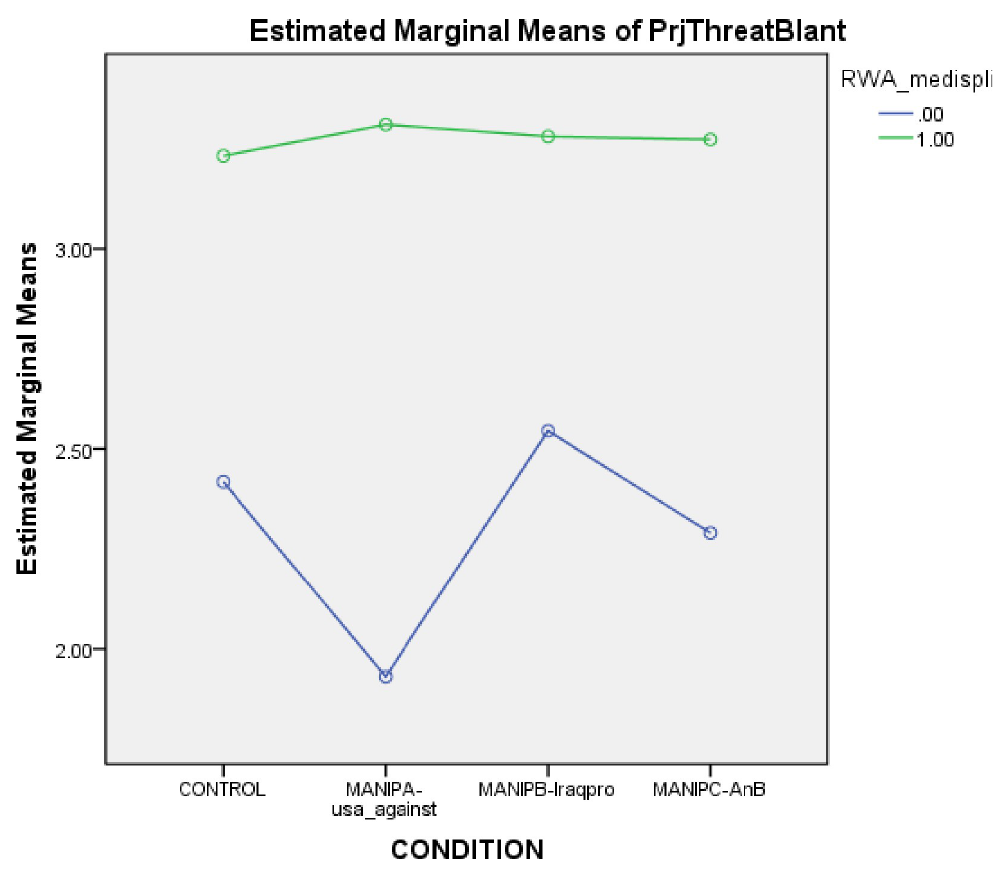
Fig 1. Condition split by RWA for blatant threat prejudice, against the four conditions of control, message A (against prejudice) message B (Iraq for prejudice) and message A&B combined.